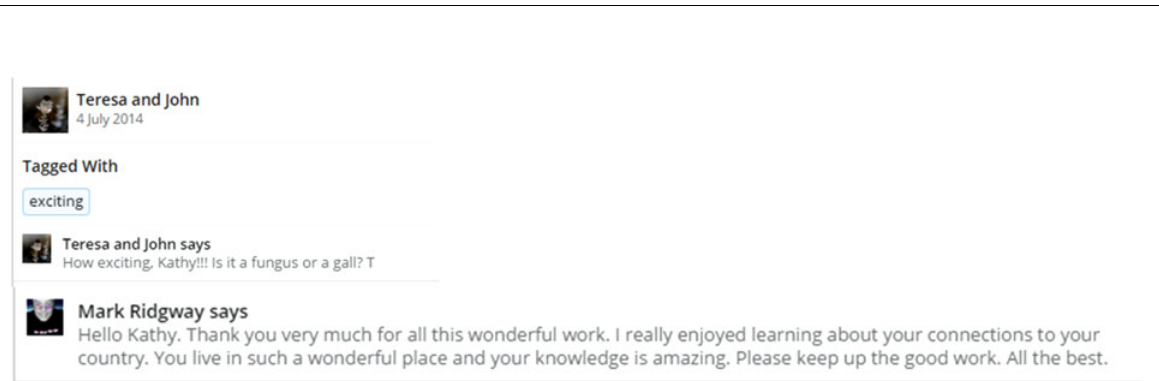
(Colour online) Members of the BowerBird community expressed their